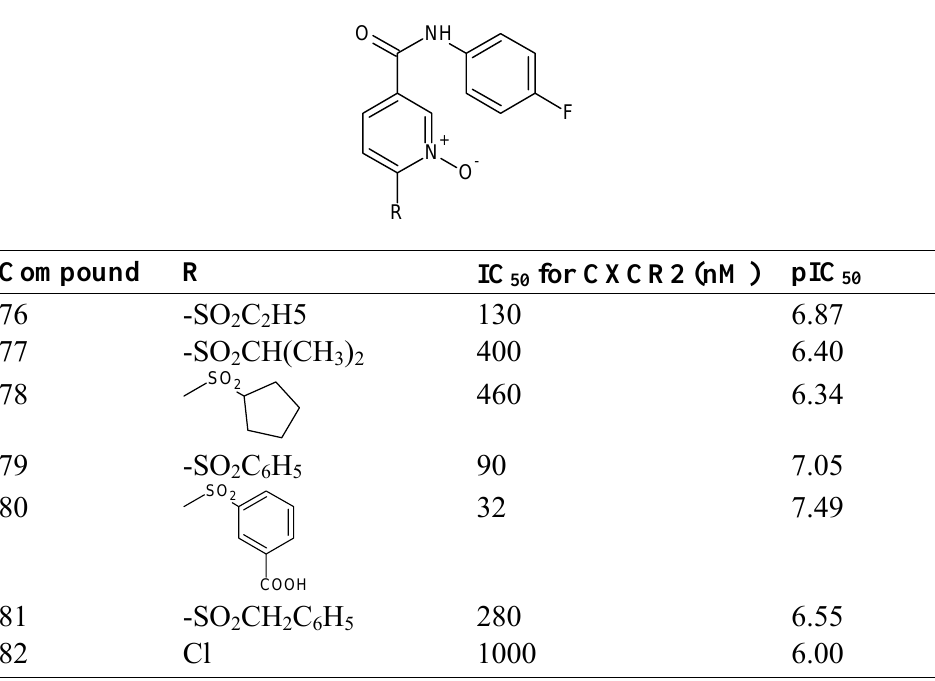
Table 4. Structures and biological activities of the nikotinamide N -oxides derivatives.